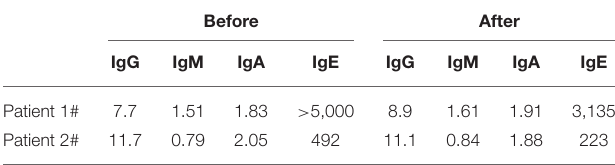
TABLE 1 | Sera antibodies levels before and after Dupilumab